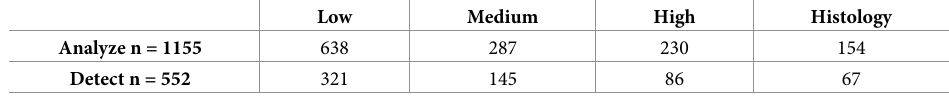
Table 2. Assignment of the lesions to the respective risk groups by the